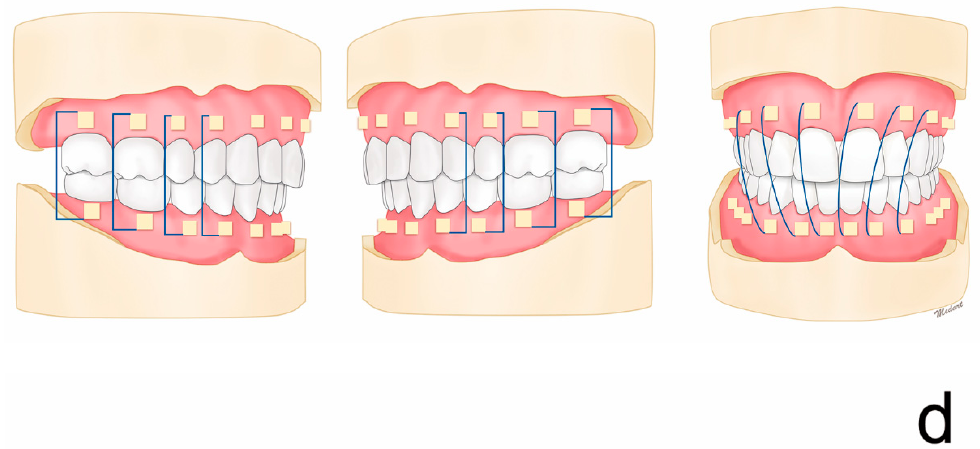
Figure 3. Measurement sites. ( a ) Mesiodistal within-arch measurements in the maxillary arch. ( b ) Mesiodistal within-arch measurements in the mandibular arch. ( c ) Transverse within-arch measurements. ( d ) Inter-arch measurements.